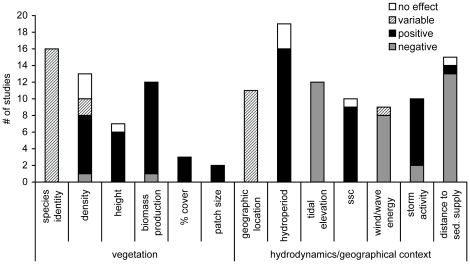
The factors most commonly quoted as being of importance to the shoreline stabilization capacity of salt marshes.An effect is positive if an increase in the factor results in an increase in shoreline stabilization as measured by increases in accretion or marsh surface height or a reduction in lateral erosion. The effect of an increase in each factor on shoreline stabilization is indicated by the bar fill.